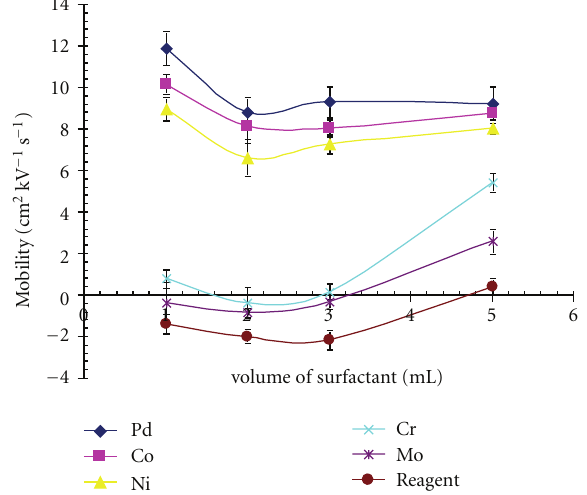
Figure 3: Variation in mobility with volume of surfactant under optimized conditions.